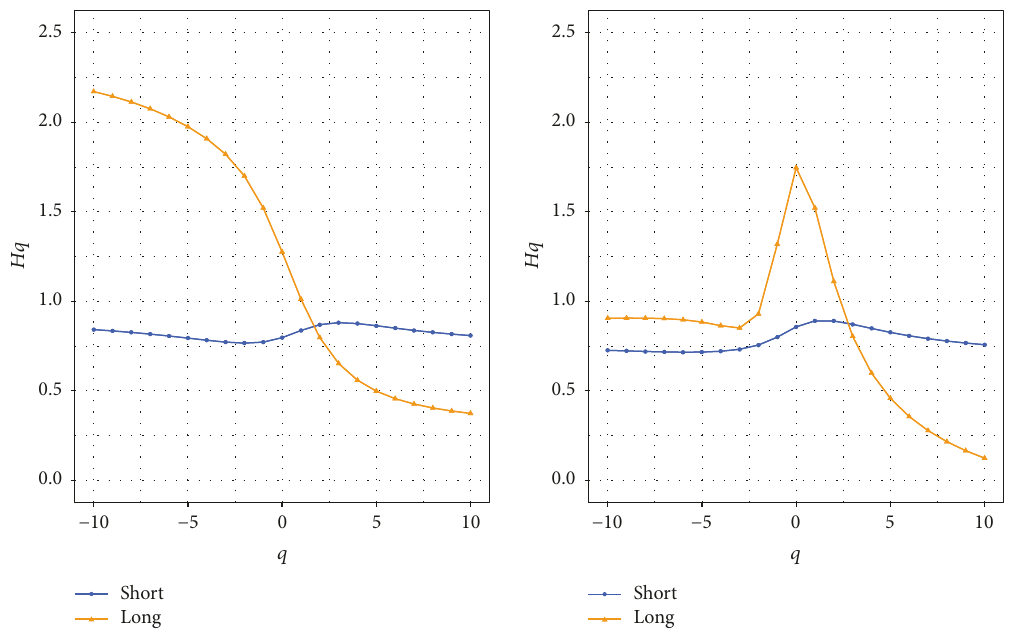
Figure 10: Short and long scaling exponents for TM-Return and NM-Return.